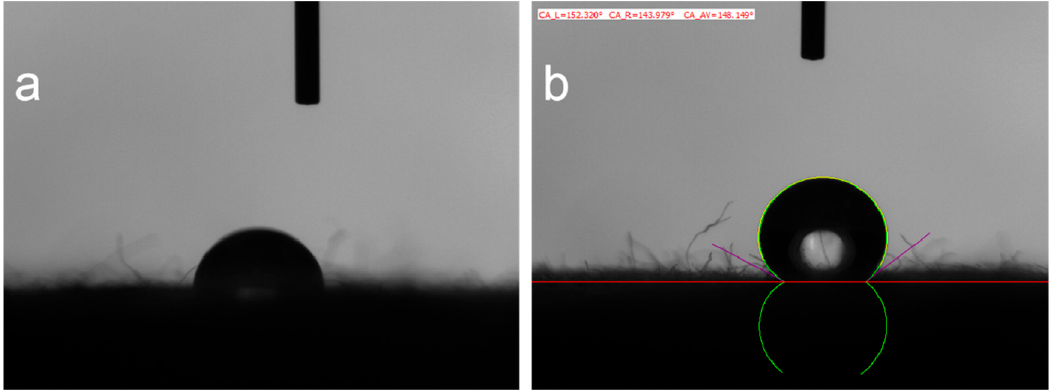
Figure 5. Water contact angle of untreated ( a ) and treated ( b ) cotton fabrics.